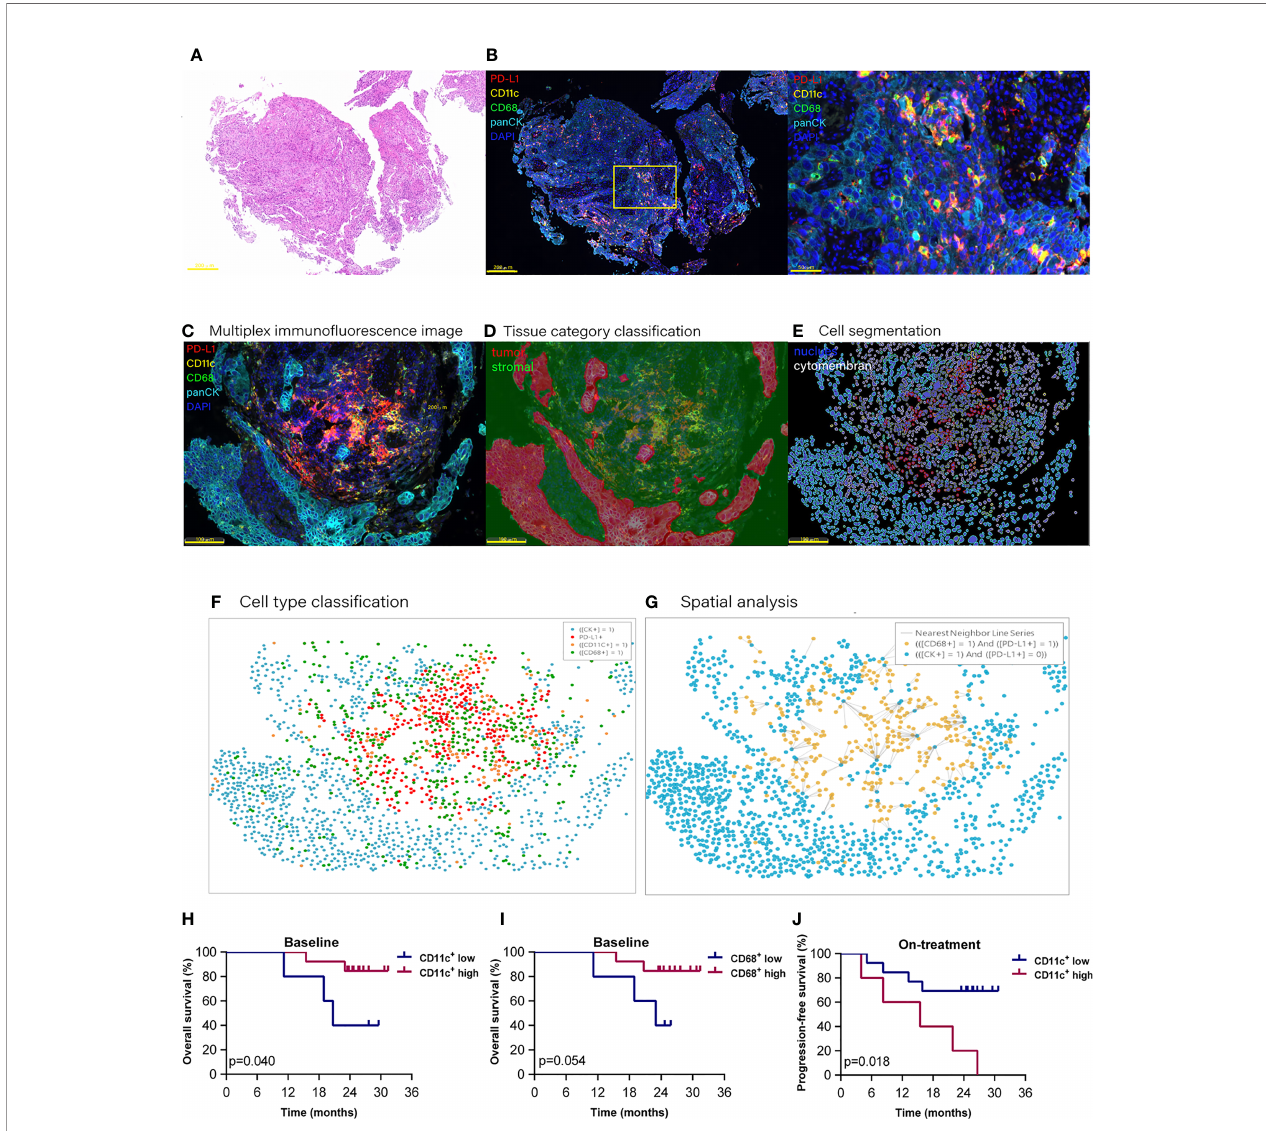
FIGURE 1 | Proportion of dendritic cells and macrophages in the tumor compartment associated with improved survival. Hematoxylin and eosin staining (A) and multiplex immuno fl uorescence staining (B) for dendritic cells and macrophages in a tissue section (case n = 14, before treatment). (B) Right, Enlarged area of the yellow frame in left. (D – G) Spatial analysis procedure (case n = 6, before treatment). Kaplan – Meier curves showing overall or progression-free survival of ESCC patients based on the proportion of dendritic cells or macrophages in (H, I) the baseline tumor compartment and (J) on-treatment stromal compartment. Cutoff value: (H) 2.987%;